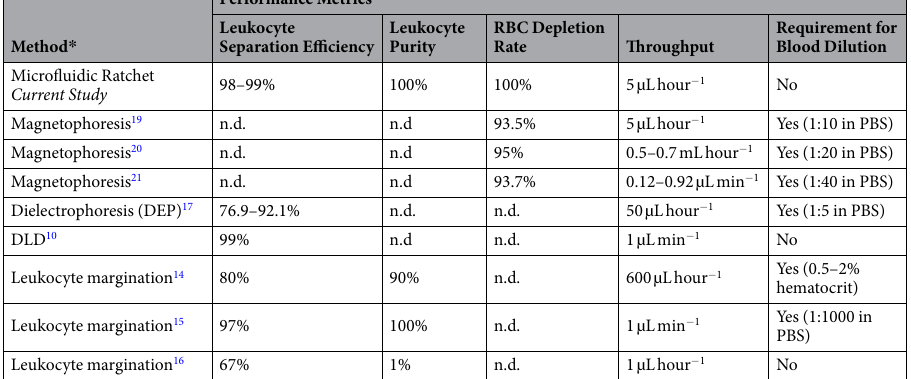
Table 2. Performances specifications of recent microfluidic research in leukocytes separation from whole blood using biophysical methods. n.d. Data not available. * References in